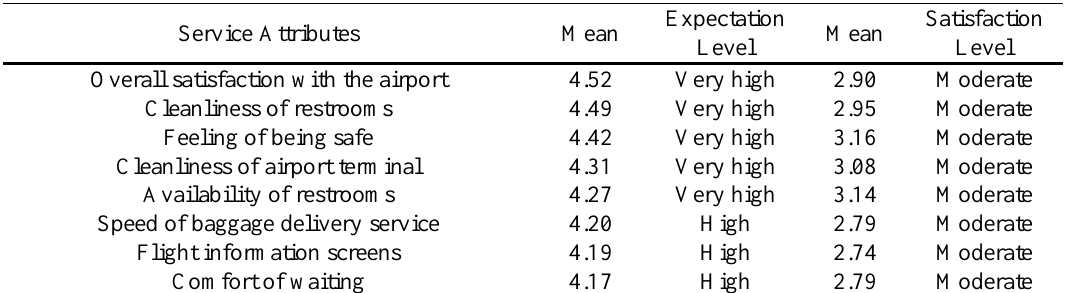
Table 1 . Descriptive analysis of airport service